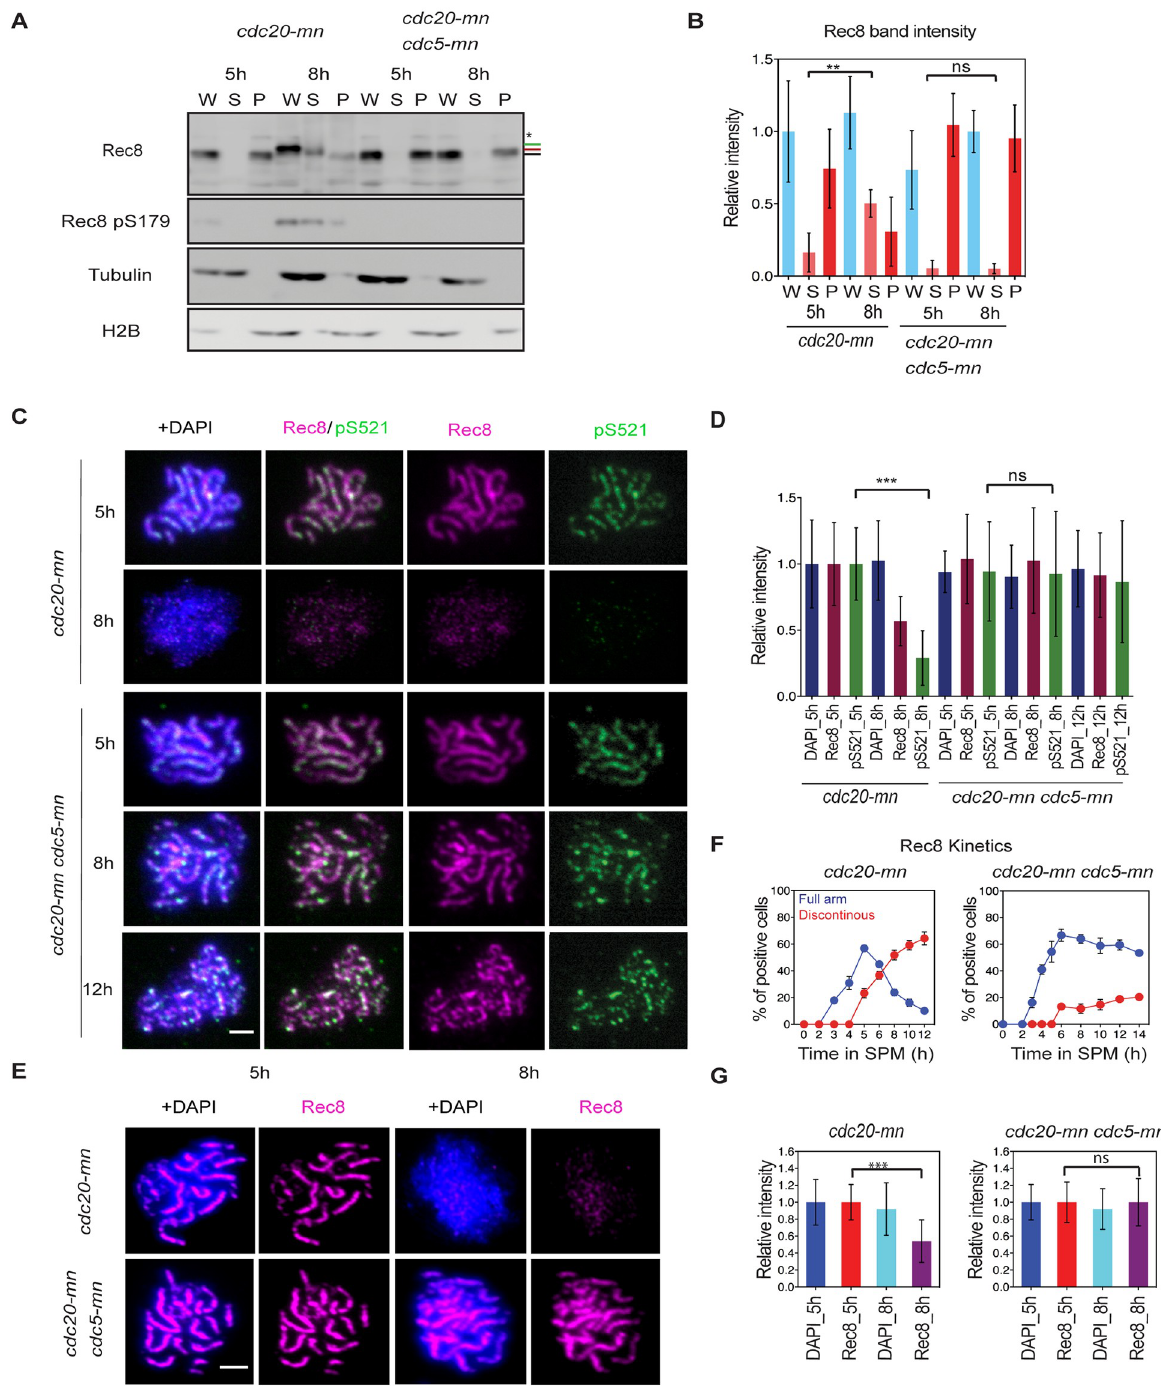
Fig 3. Rec8 phosphorylation is required for efficient dissociation of Rec8 at late prophase-I. (A) Chromatin fractionation assay for cdc20-mn (KSY642/643) and cdc20-mn cdc5-mn (KSY659/660) mutant cells was carried out as described in Fig 2A. (B) Quantification of Rec8 band intensity in (A) is performed as shown in Fig 2B. Error bars show the variation (n = 2). (C) Localization of Rec8 (red) and Rec8-pS521 (phospho-S521; green) was analyzed in cdc20-mn (KSY642/643) cdc20-mn cdc5-mn (KSY659/660) cells at 5, 8 and 12 h. (D) Total Rec8, Rec8-pS521, and DAPI signal intensity was studied as in Fig 1C. Error bars show the S.D. (n = 3). (E) Localization of Rec8 (red) with or without DAPI (blue) in CDC20-mn (KSY642/643) and CDC20-mn CDC5-mn (KSY659/660) mutants. Representative image is shown. The bar indicates 2 μ m. (F) Kinetics of Rec8 in (E) was classified as shown in Fig 1B. Error bars show the S.D. (n = 3). (G) Total Rec8 and DAPI signal intensity was quantified as shown in Fig 1C. A minimum 30 nuclei were quantified in each representative time points. Error bars show the S.D. (n = 3).